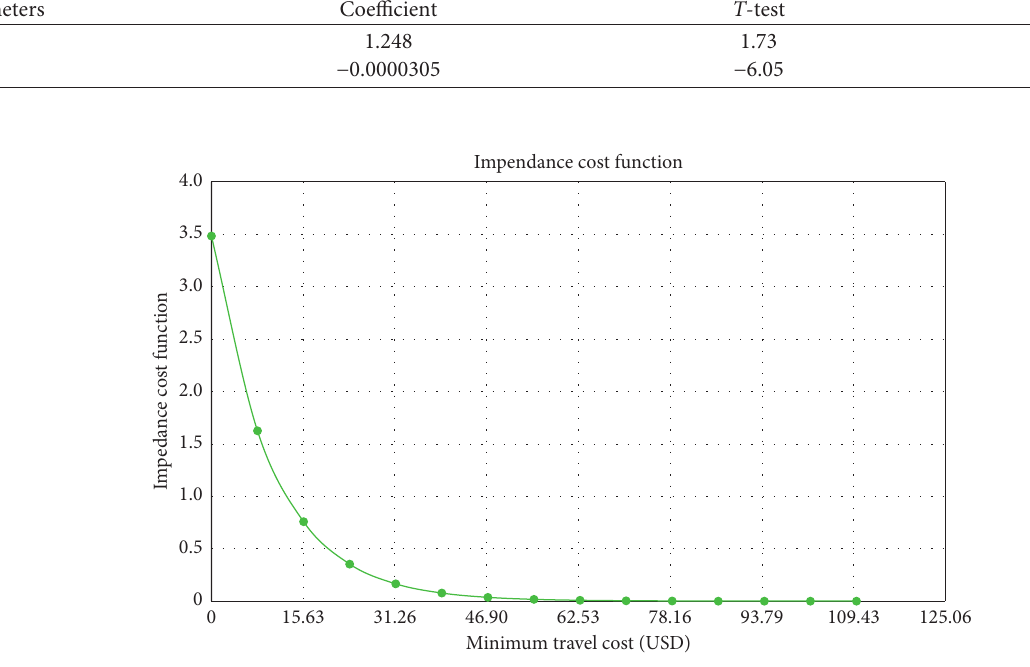
Figure 6: Impedance cost